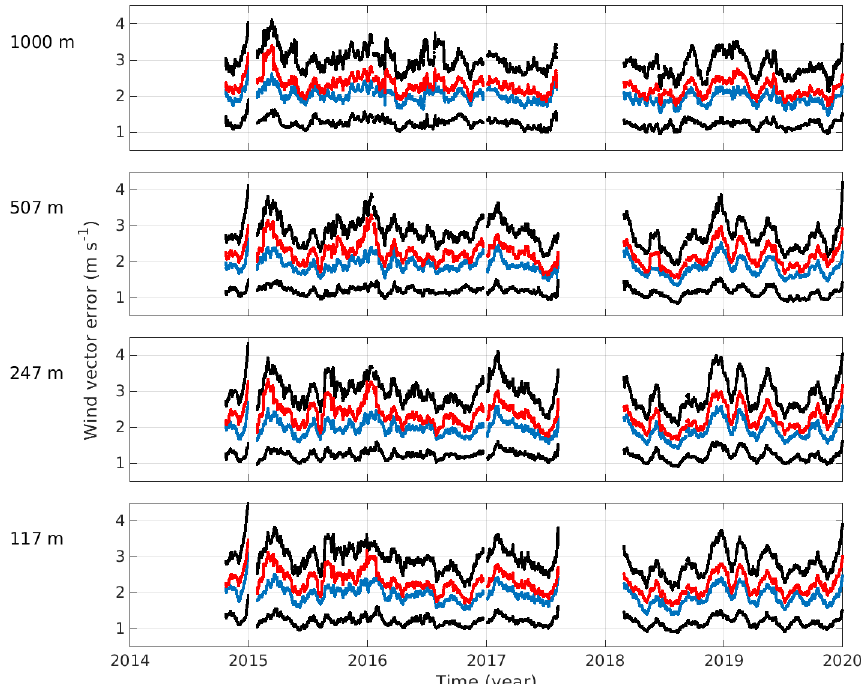
Figure A4. Time series of 30d moving mean (red), median (blue), and 25th and 75th percentiles (black) of wind vector error over Graciosa at 117, 247, 507, and